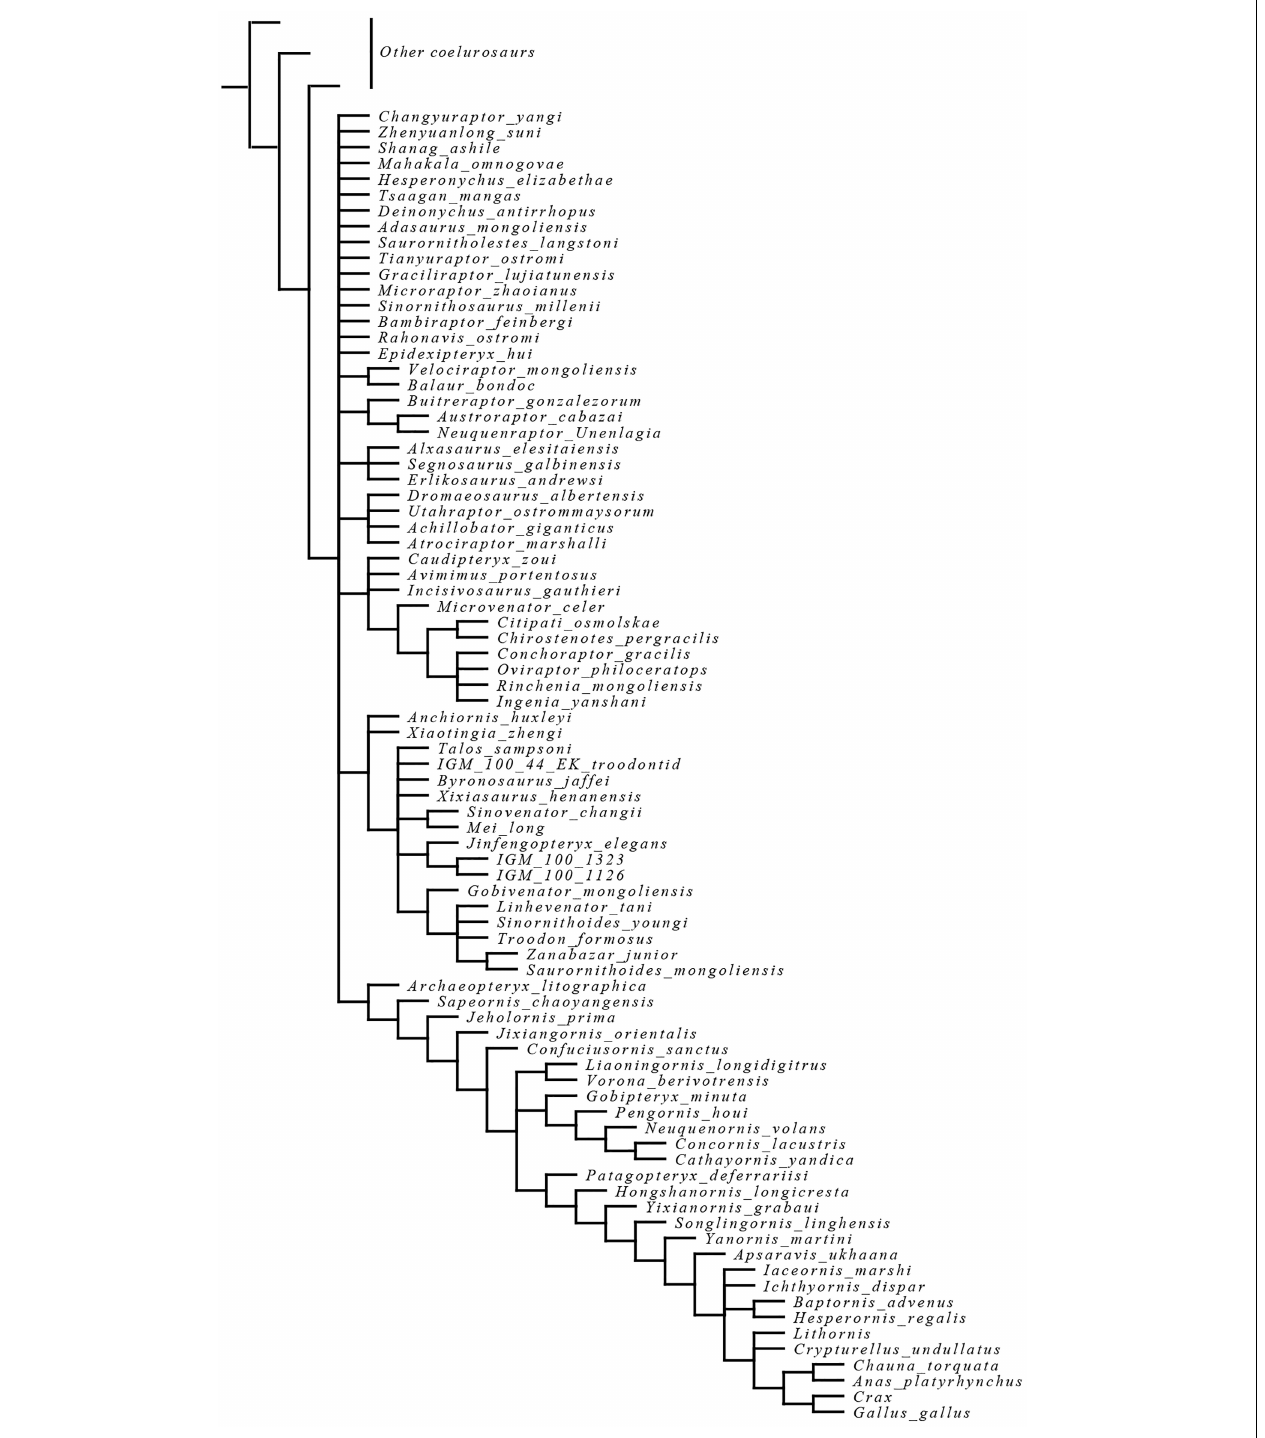
FIGURE 8 | Strict consensus tree based on modified TWiG data matrix. Using this modified version of the matrix, the phylogenetic relationships of basal paravians are not resolved.